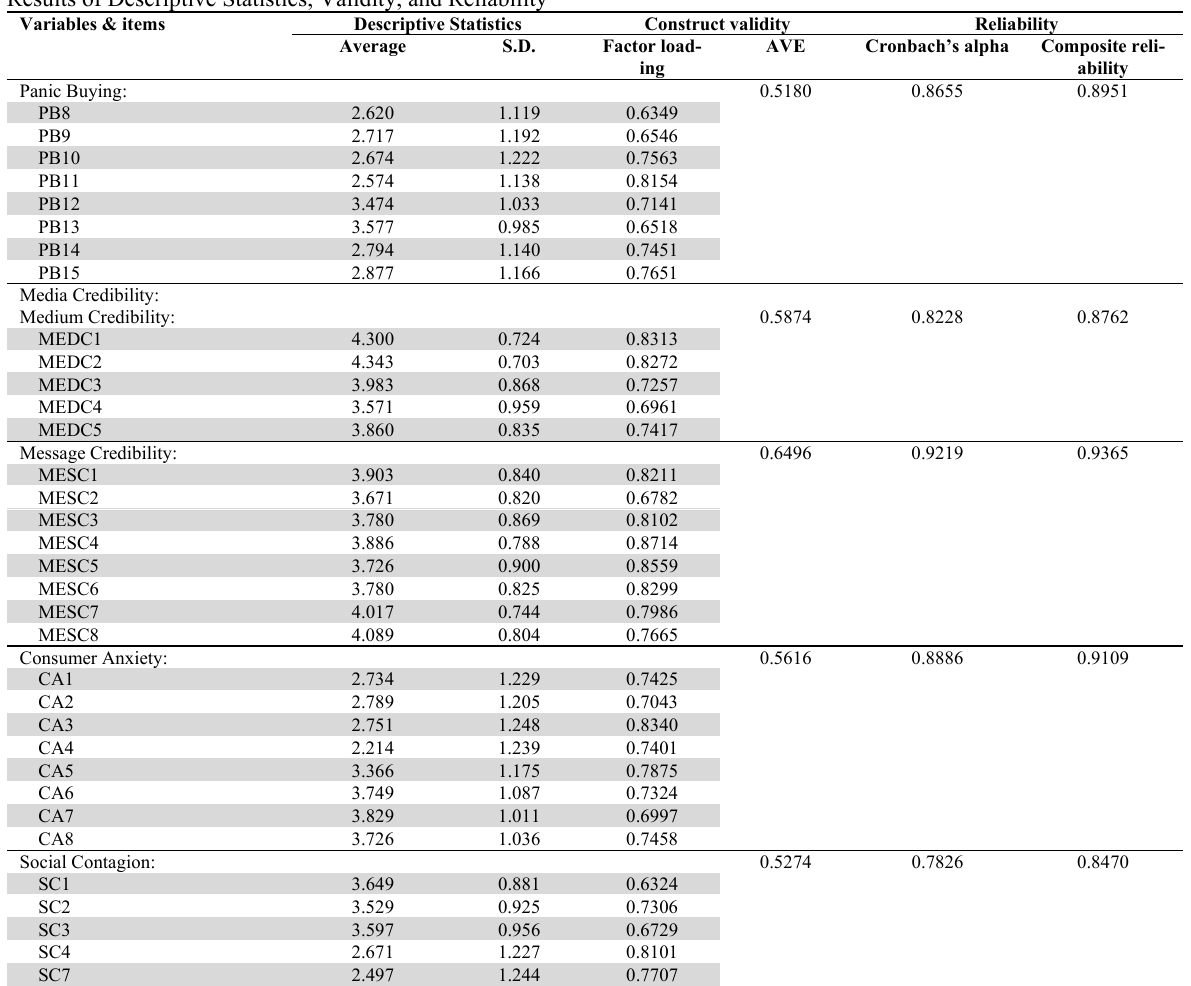
Fig. 1. Profile of Respondents Descriptive Statistics Results of Descriptive Statistics, Validity, and